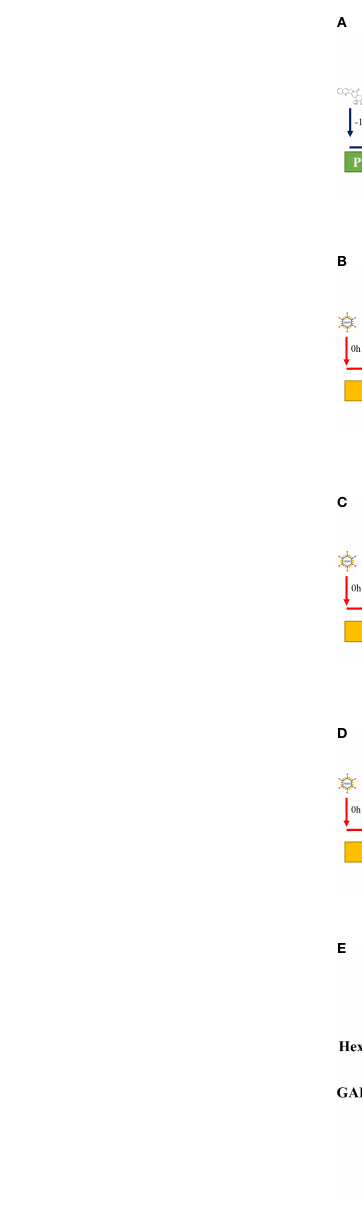
FIGURE 3 | Effect of camptothecin on the attachment, entry, replication, and release of FAdV-4. FAdV-4 infected LMH cells and added camptothecin in different life cycles of the virus. The FAdV-4 DNA levels in LMH cells were measured using qPCR. (A) Virus attachment assay. (B) Virus entry assay. (C) Virus replication assay. (D, E) Virus release assay. All experiments were performed in triplicate ( n = 3). Error bars represent the standard deviation. The asterisks in the fi gures indicate signi fi cant differences (* P < 0.05; ** P < 0.01; ns, not signi fi